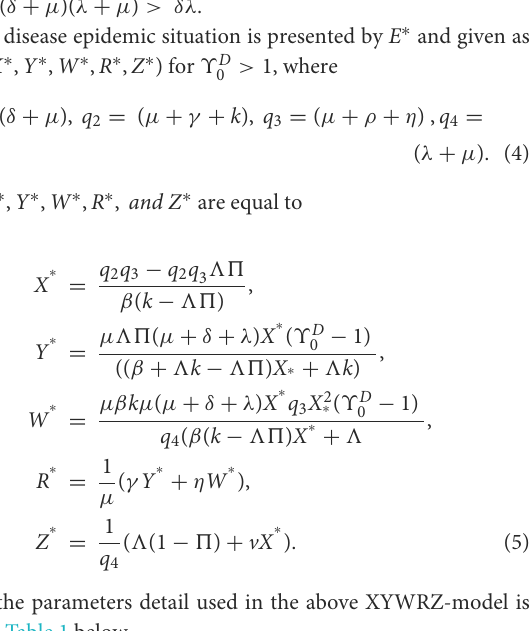
TABLE 1 Parameters involved in the above XYWRZ-model